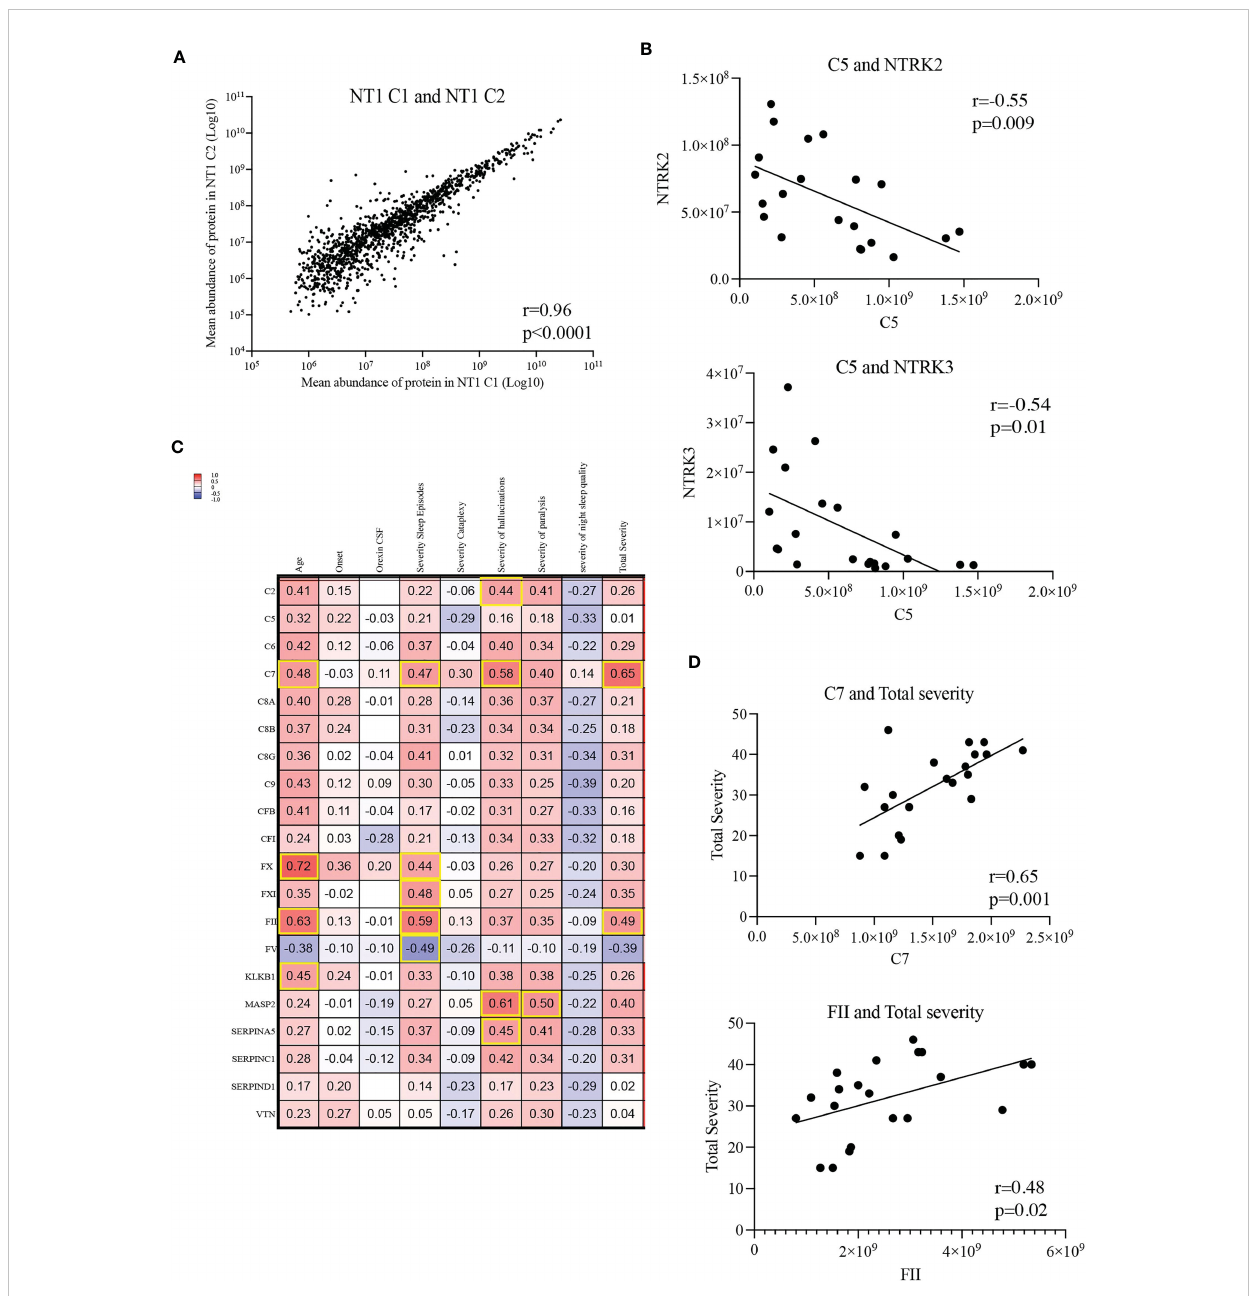
FIGURE 6 Correlations between complement and coagulation proteins and clinical parameters. (A) Correlation of mean abundance of all quanti fi ed common proteins shared between NT1 patients of both cohorts. (B) Inverse correlation between the abundance of protein C5 with that of NTRK2/TrkB and NTRK3/TrkC in the CSF of the 21 studied NT1 patients. (C) Shared proteins of the complement and coagulation pathways correlated with clinical parameters (age, time from onset, orexin CSF levels, severity of sleep episodes, severity of cataplexy, severity of hallucinations, severity of sleep paralysis, severity of night sleep disruption and total disease severity). All NT1 patients from both cohorts were included in this analysis. The values in the heatmap represent the coef fi cients of correlation assessed with Pearson test and highlighted squares represent statistically signi fi cant correlations. (D) Correlation of proteins C7 and FII with NT1 total